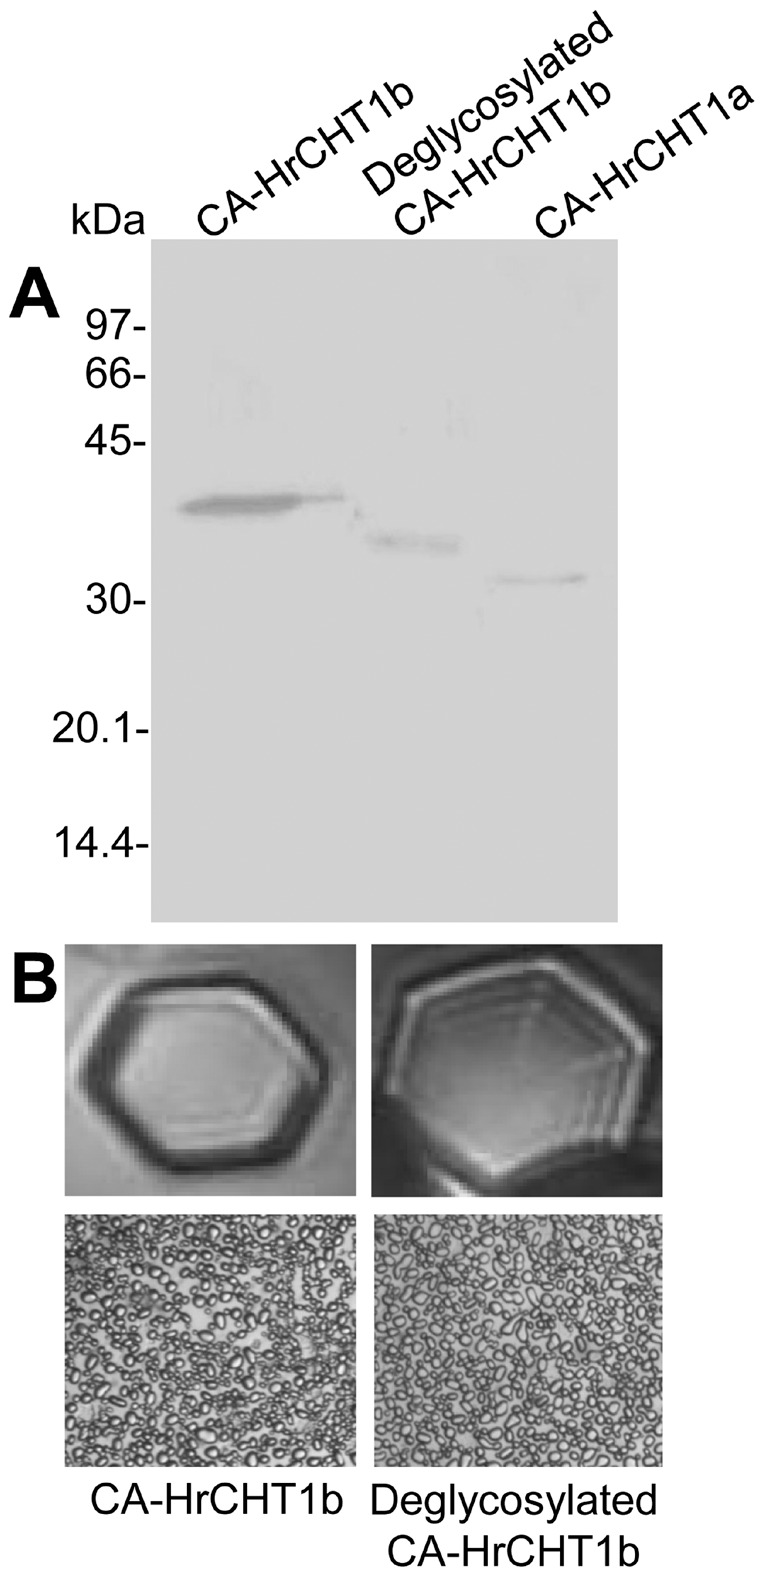
Deglycosylation of HrCHT1b.(A) SDS-PAGE profile showing deglycosylation of HrCHT1b using trifluromethanesulphonic acid. Antifreeze activity analysis of the glycosylated and deglycosylated HrCHT1b (B) by observing ice crystal morphology (upper panel) and ice recrystallization inhibition (lower panel).